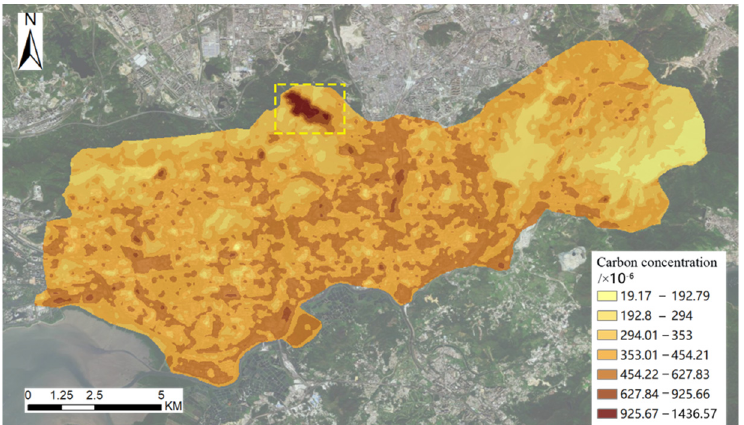
Figure 8. Distribution of CO 2 concentration in the study area (the yellow dotted line is the abnormal value area).